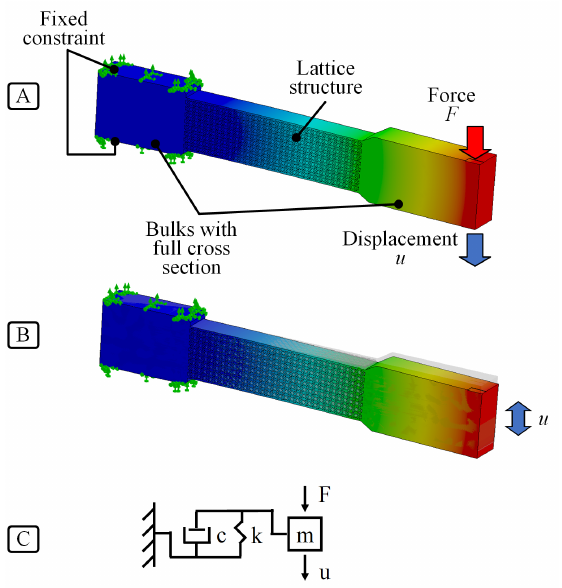
Figure 1. Specimen design and SDOF model: longitudinal section view of the beam-like specimen under linear static FEA ( A ) and under modal FEA ( B ); equivalent single harmonic oscillator model ( C ). A cubic unit cell with FBCCZ topology, 2 mm cell size, and 0.4 mm strut diameter was